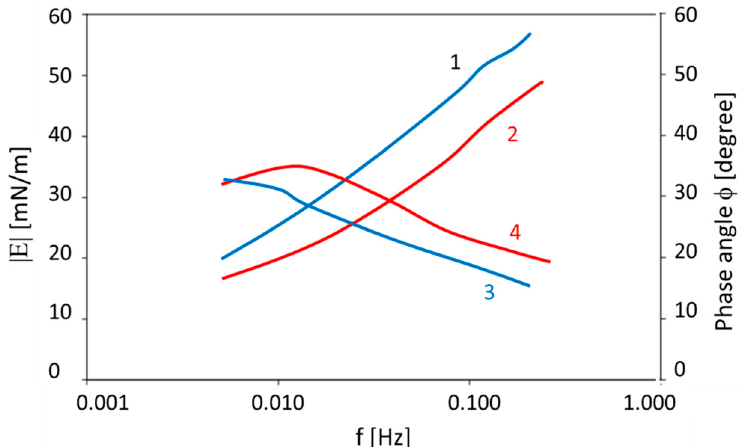
Figure 3. The visco-elastic modulus |E| (1, 2) and phase angle (3, 4) values as a function of the oscillation frequency f measured for blood serum: before the operation (2, 4) and after the re-canalization of the biliary tract (1, 3); data taken with permission from [30].